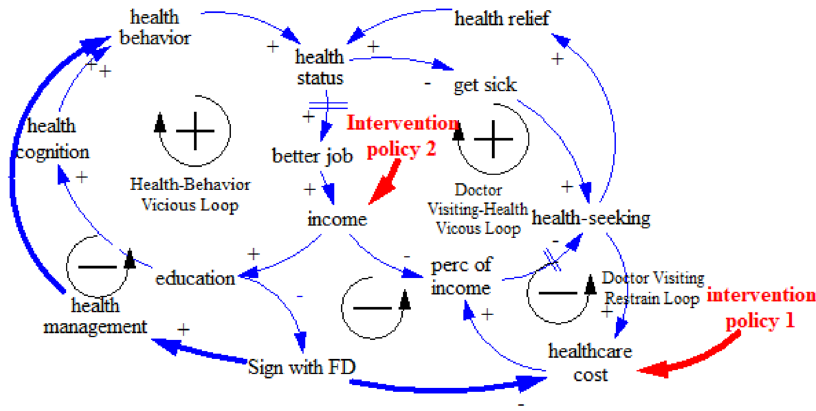
Figure 3. Causal loop of SES–FD–health disparity with policy interventions.